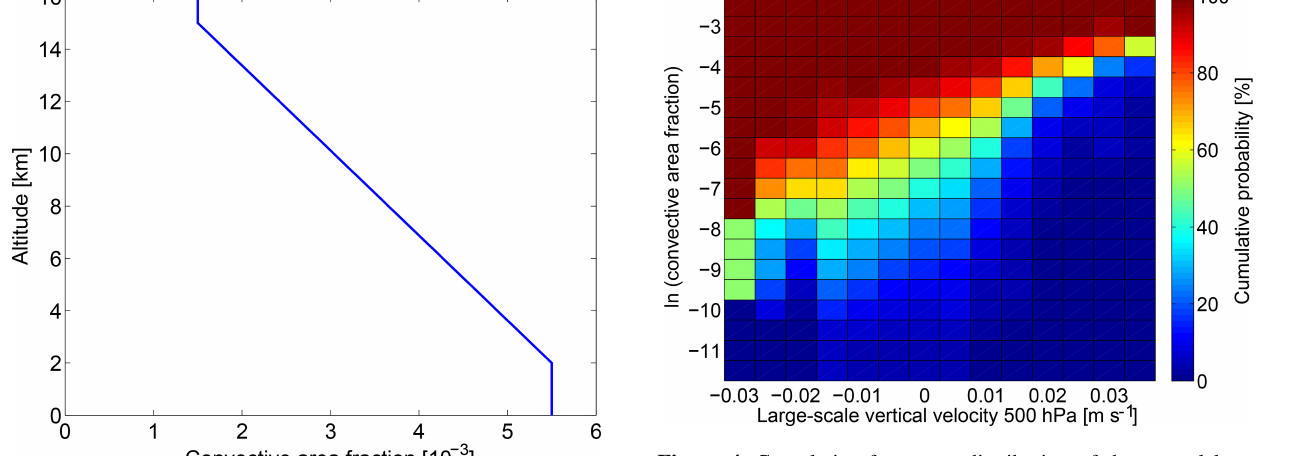
Figure 4. Cumulative frequency distribution of the natural loga- rithm of the convective area fraction from a combined Darwin– Kwajalein CPOL radar dataset as a function of the large-scale ver- tical velocity at 500hPa. The distribution is used to calculate the vertical updraft velocities in the